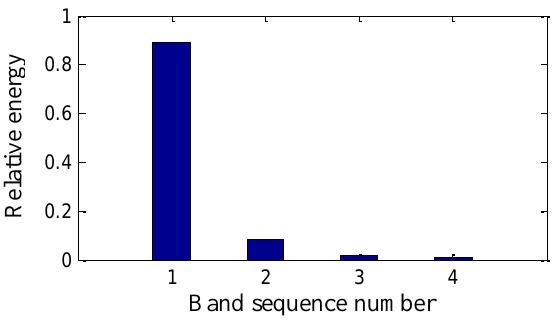
Figure 15. Signal analysis by the second generation wavelet package in level 2 after maintenance.